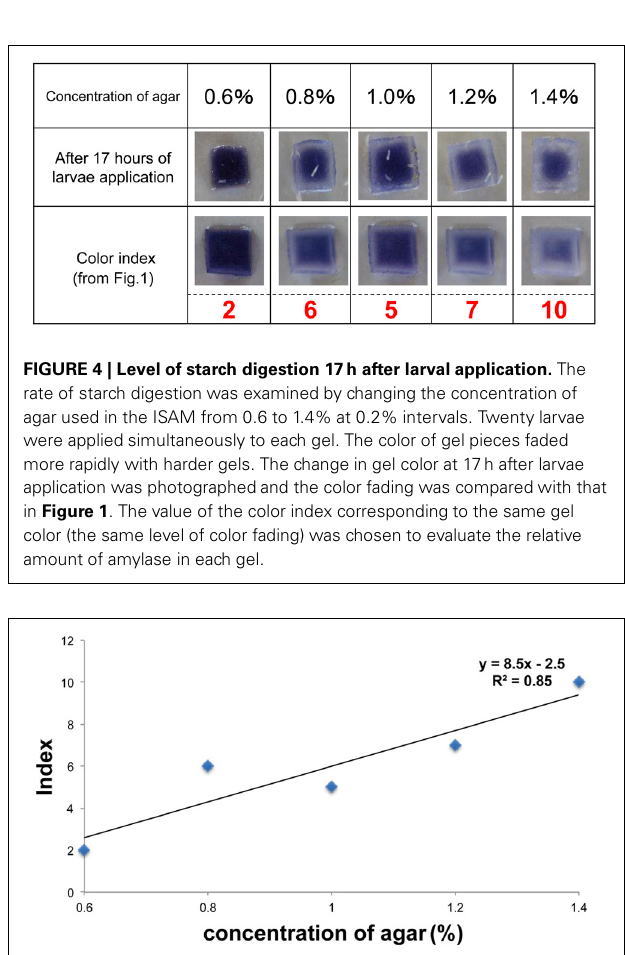
FIGURE 5 | Relation between food hardness and the amount of amylase. The values of the color index in each agar concentration are plotted on the graph. The vertical axis represents the color index and the horizontal axis represents the concentration of agar. The value of the color index increased with a concomitant increase in the agar concentration.